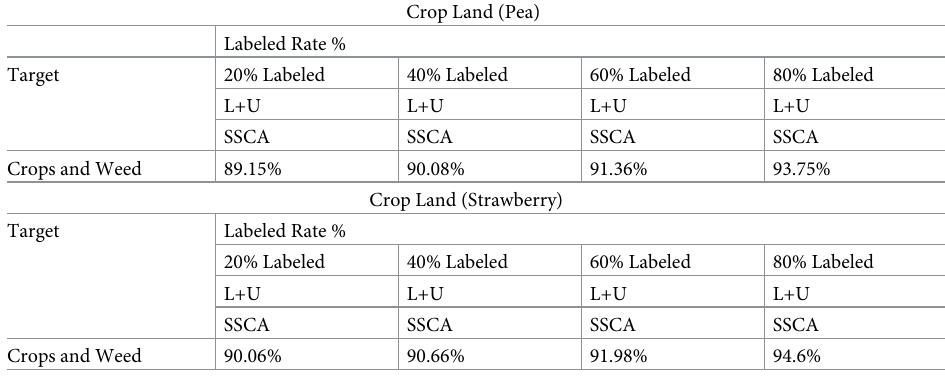
Table 3. Classification accuracy of our proposed semi-supervised learning method under different labeled